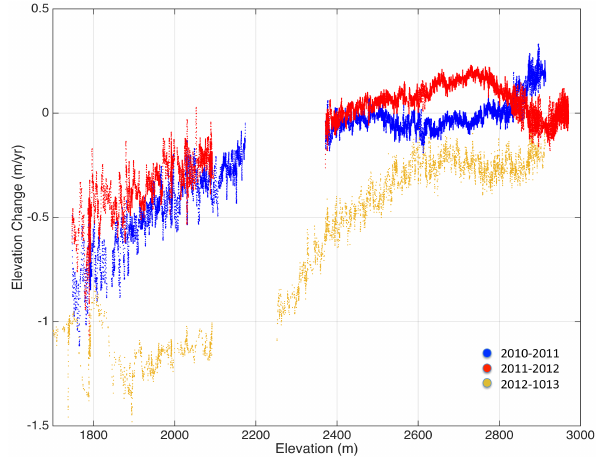
Figure 5. Elevation change estimated from NASA ATM laser al- timeter in western Greenland along the flight path shown in Fig. 1. Estimates are for annual change in 2011 (blue), 2012 (red), and 2013